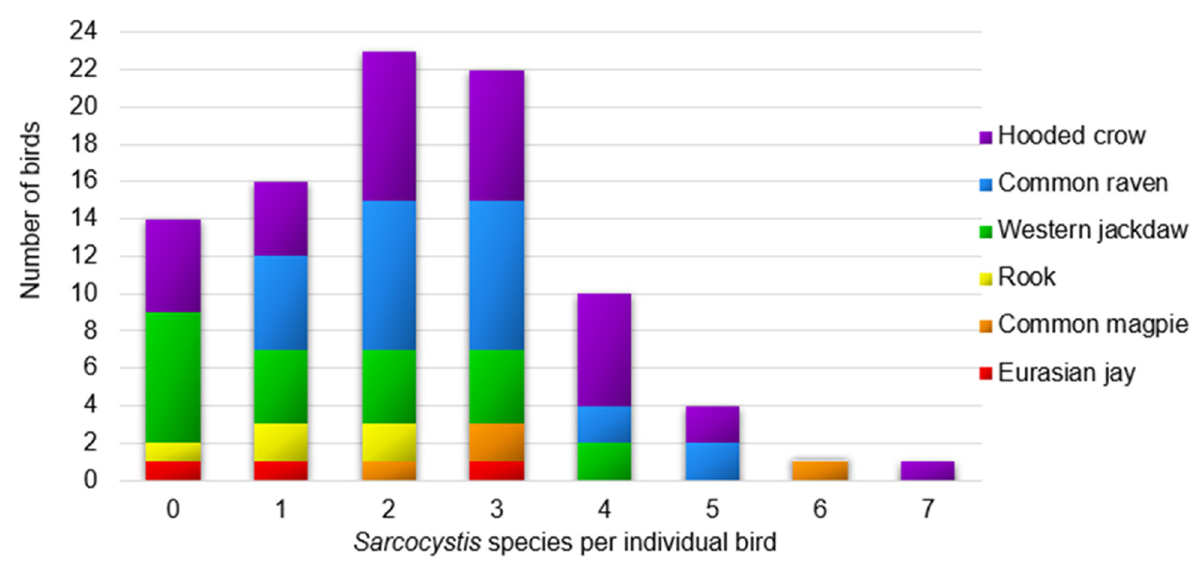
Figure 1. Distribution of the number of Sarcocystis species detected in one